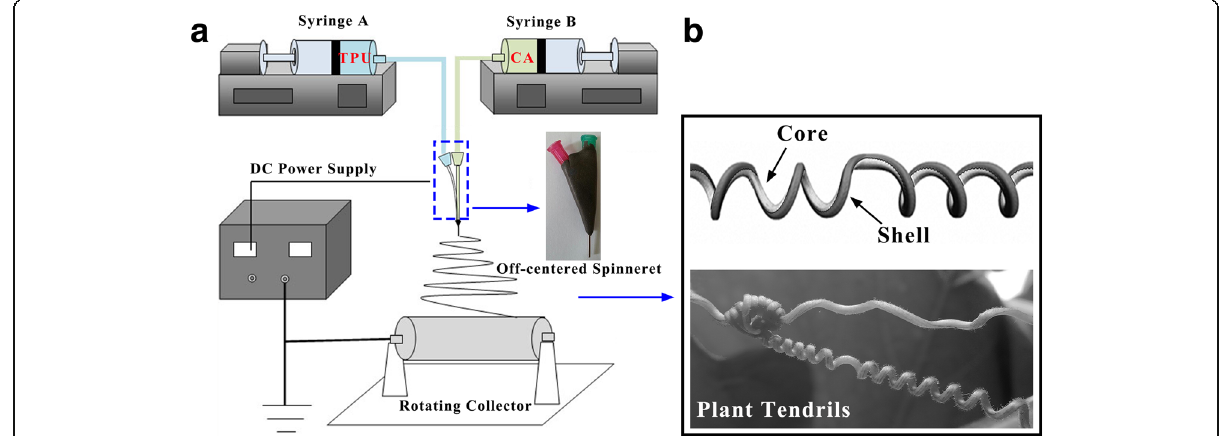
Fig. 1 a Schematic of the off-centered co-electrospinning system. b Formation mechanism of helical nanofibers